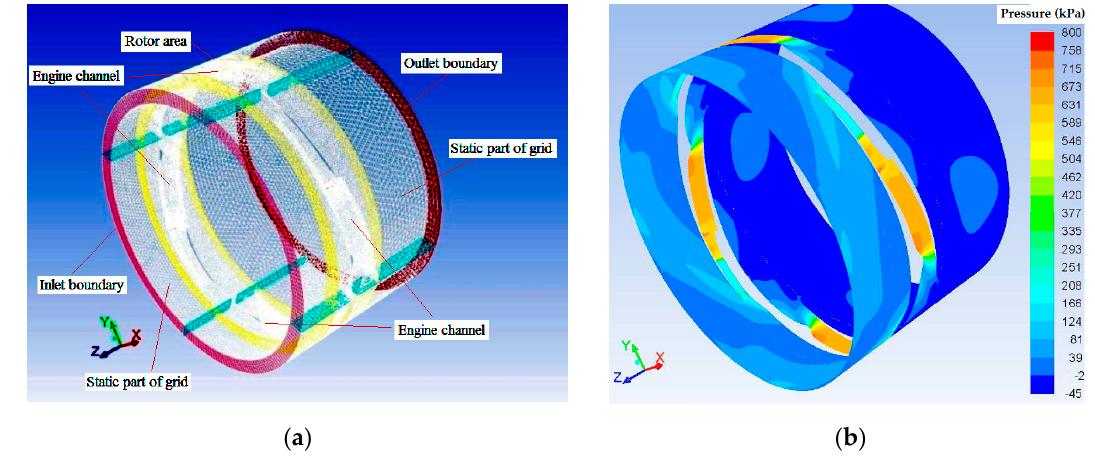
Figure 15. ( a ) The discretizing grid in a three-dimensional model and ( b ) the pressure distribution in the middle plane of the 3-D engine channels [19] (at a radius of 0.3 m).